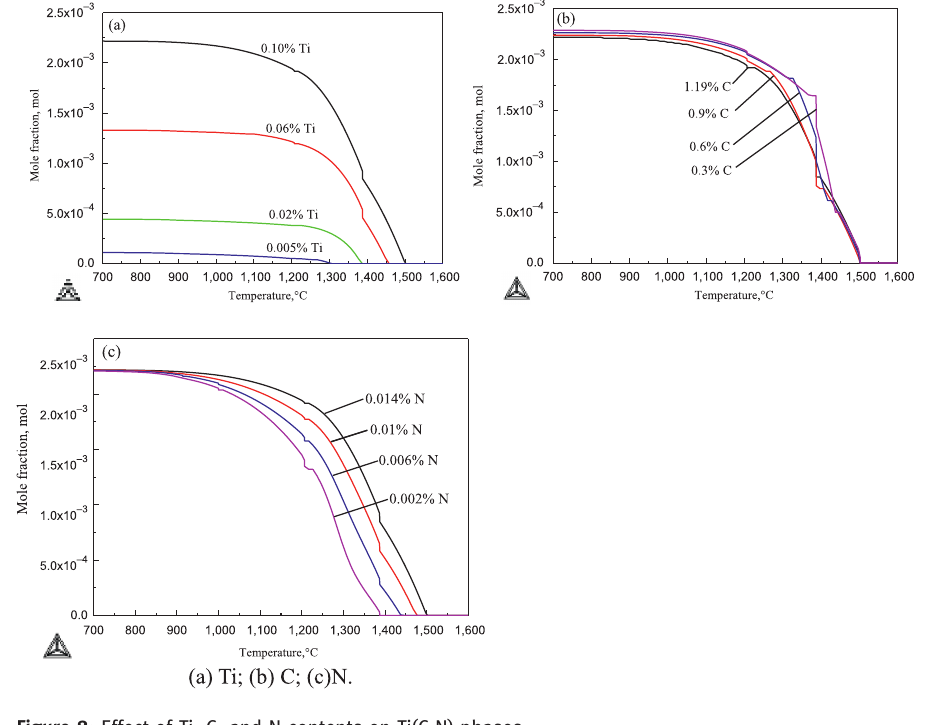
Figure 8: Effect of Ti, C, and N contents on Ti(C,N)